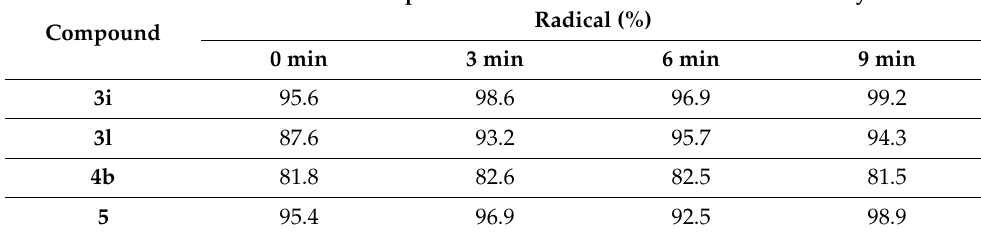
Table 4. In vitro % values for AAPH anti-lipid peroxidation activity of the most potent compounds in relation to time. Inhibition of Lipid Peroxidation of Linoleic Acid Induced by AAPH Radical (%) Compound 0 min 3 min 6 min 9 min 3i 95.6 3l